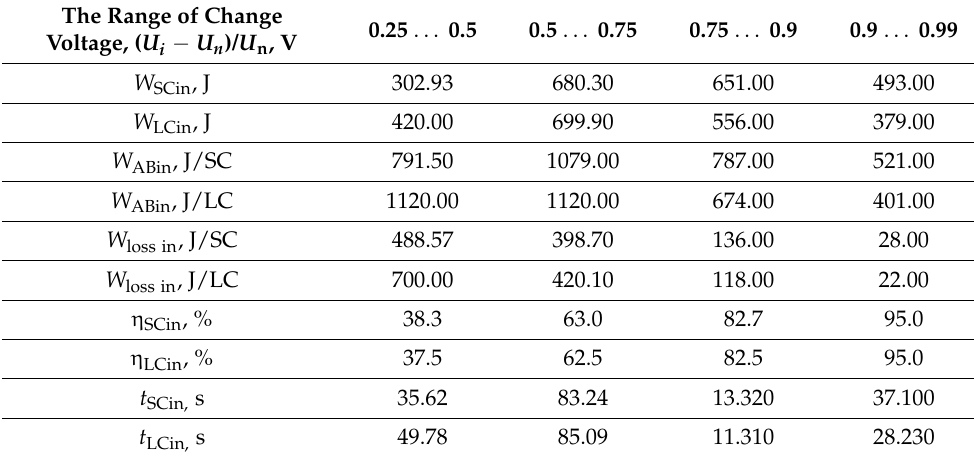
Table 4. Energy characteristics when charging a linear capacitor and a supercapacitor in different ranges of voltage